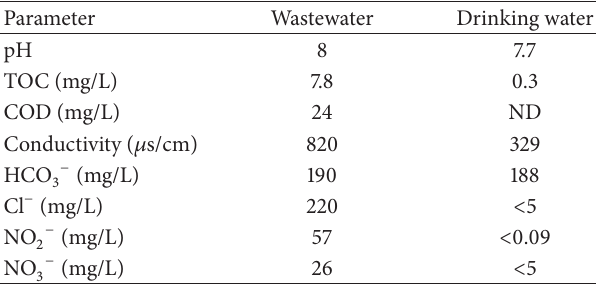
Table 1: Properties of wastewater and drinking water matrices used in this